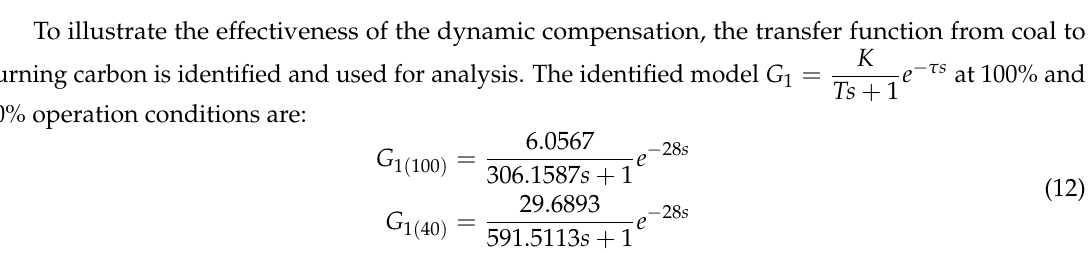
Figure 6. Control structure of fuel-main steam pressure loop based on load-burning carbon